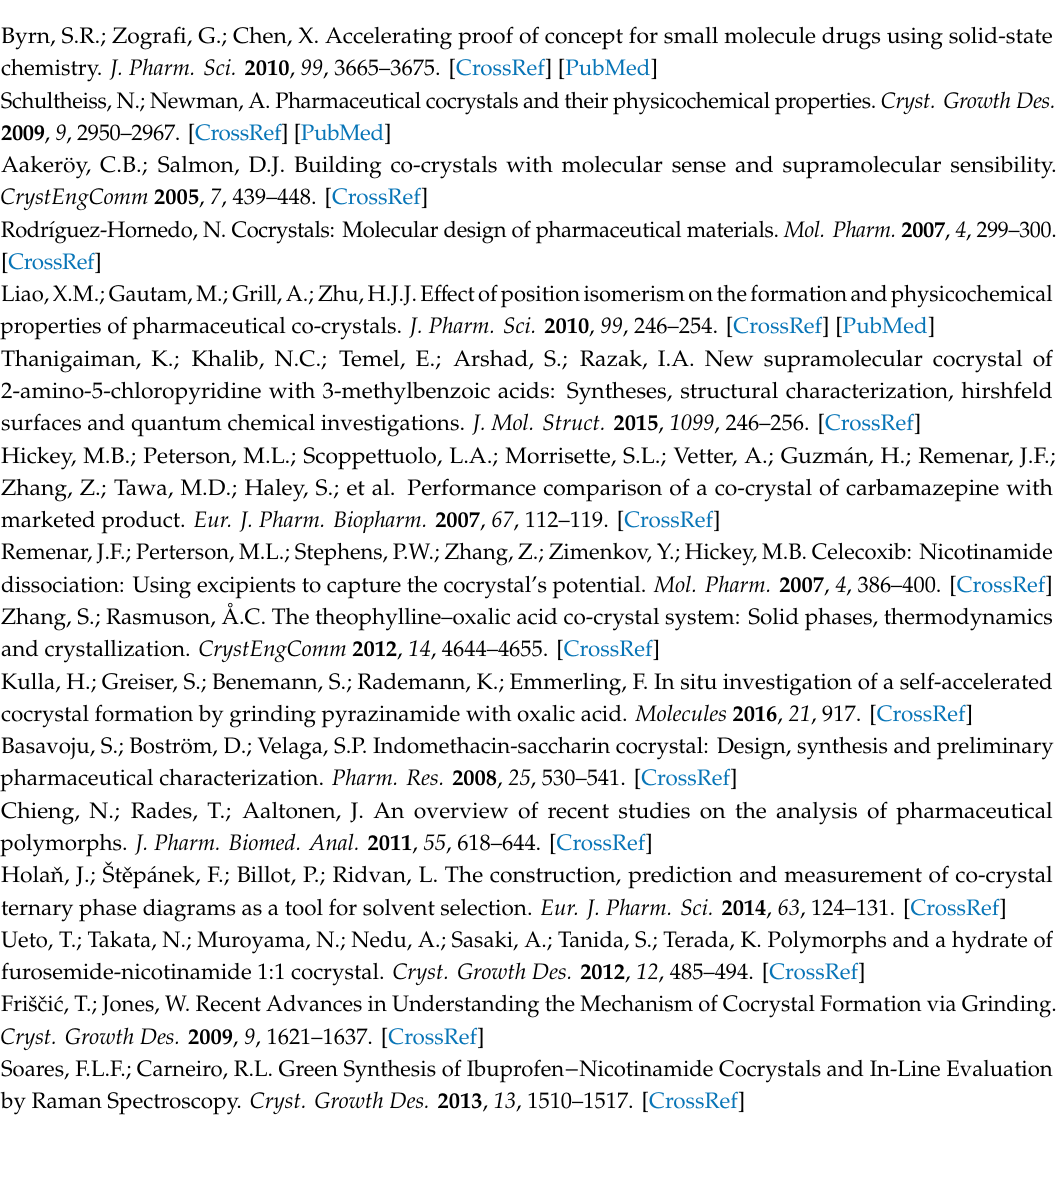
Figure S1a. Table S3: Information about Raman spectra in the range of 1120–1200 cm − 1 in Figure S2a. Table